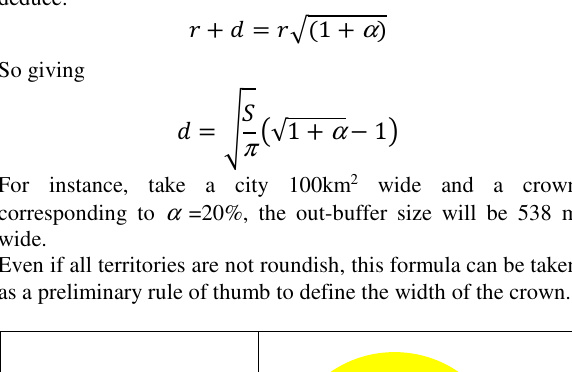
Figure 8. A circular territory with its out-buffer